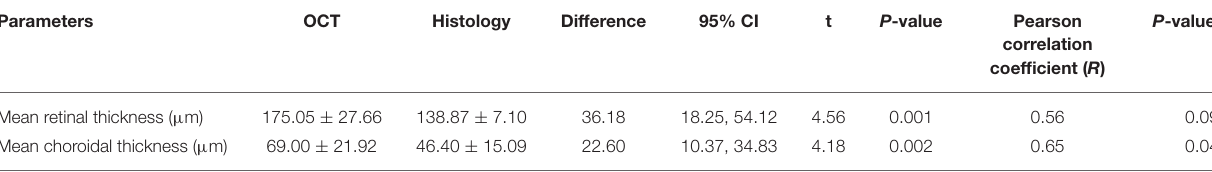
P -value for R correlation coefficient ( R )